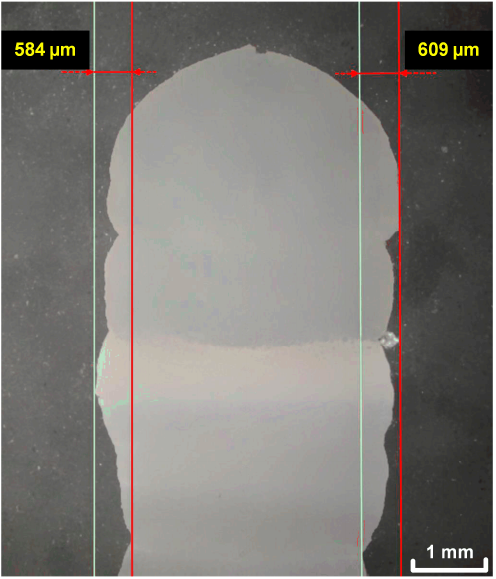
Figure 5. The local cross section at the top region of the wall (under the deposition parameters listed in Table 2).